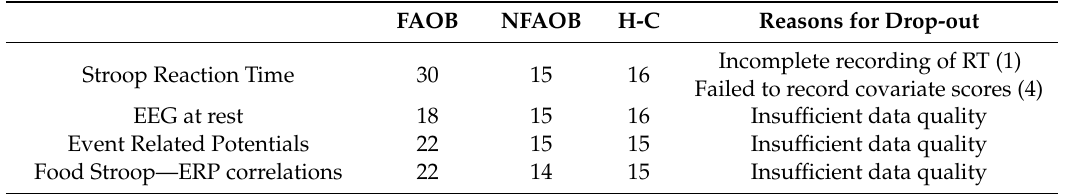
Table A2. Number of participants included in the analysis.